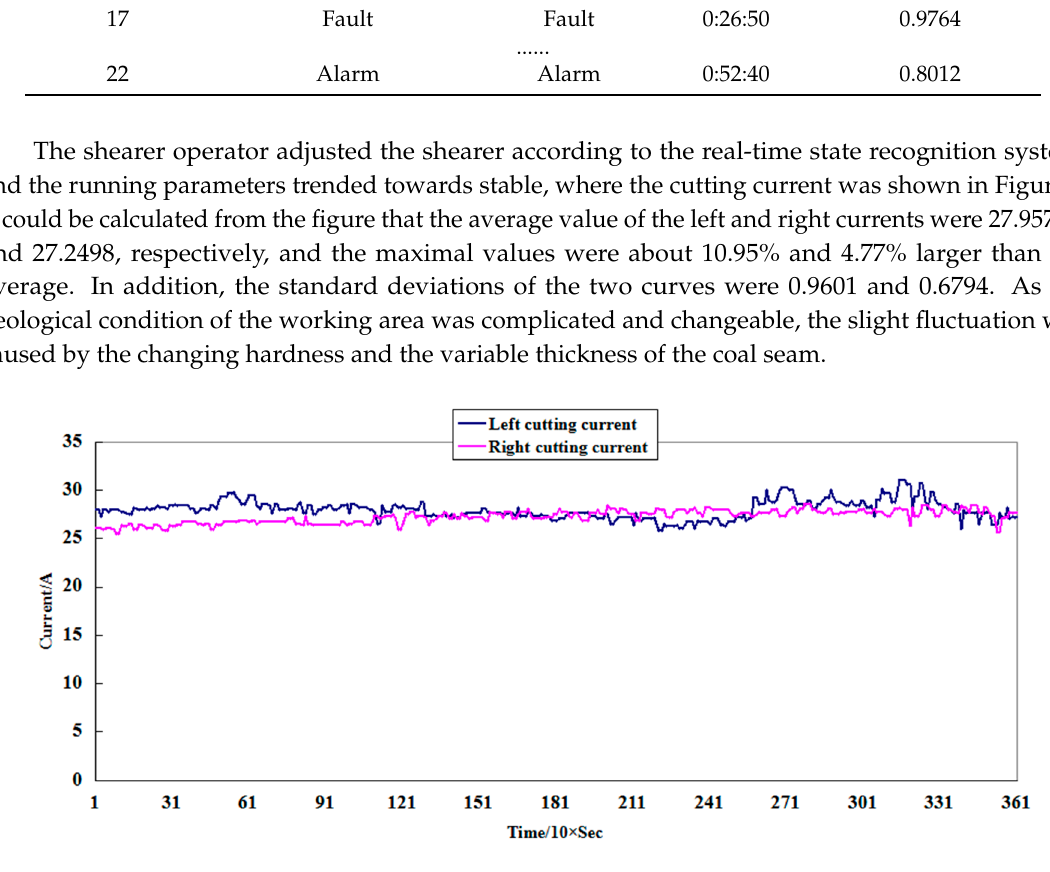
Figure 8. Cutting current